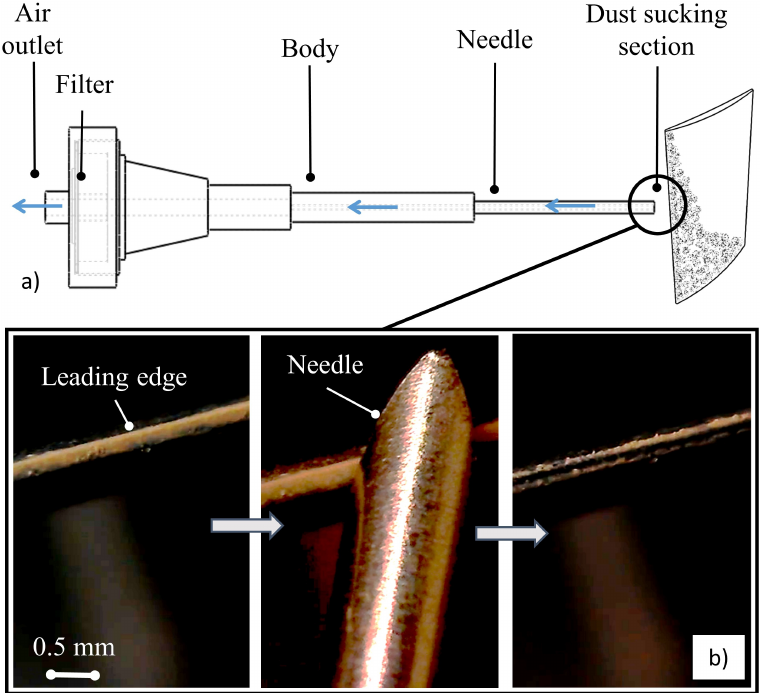
Figure 5. Particle collection device and operation: ( a ) schematic view of the localized aspirator for particle observation (LAPO), where the main zones of the device and the components are labeled and the air flow path is highlighted by the arrows; and ( b ) particle collection operation on the leading